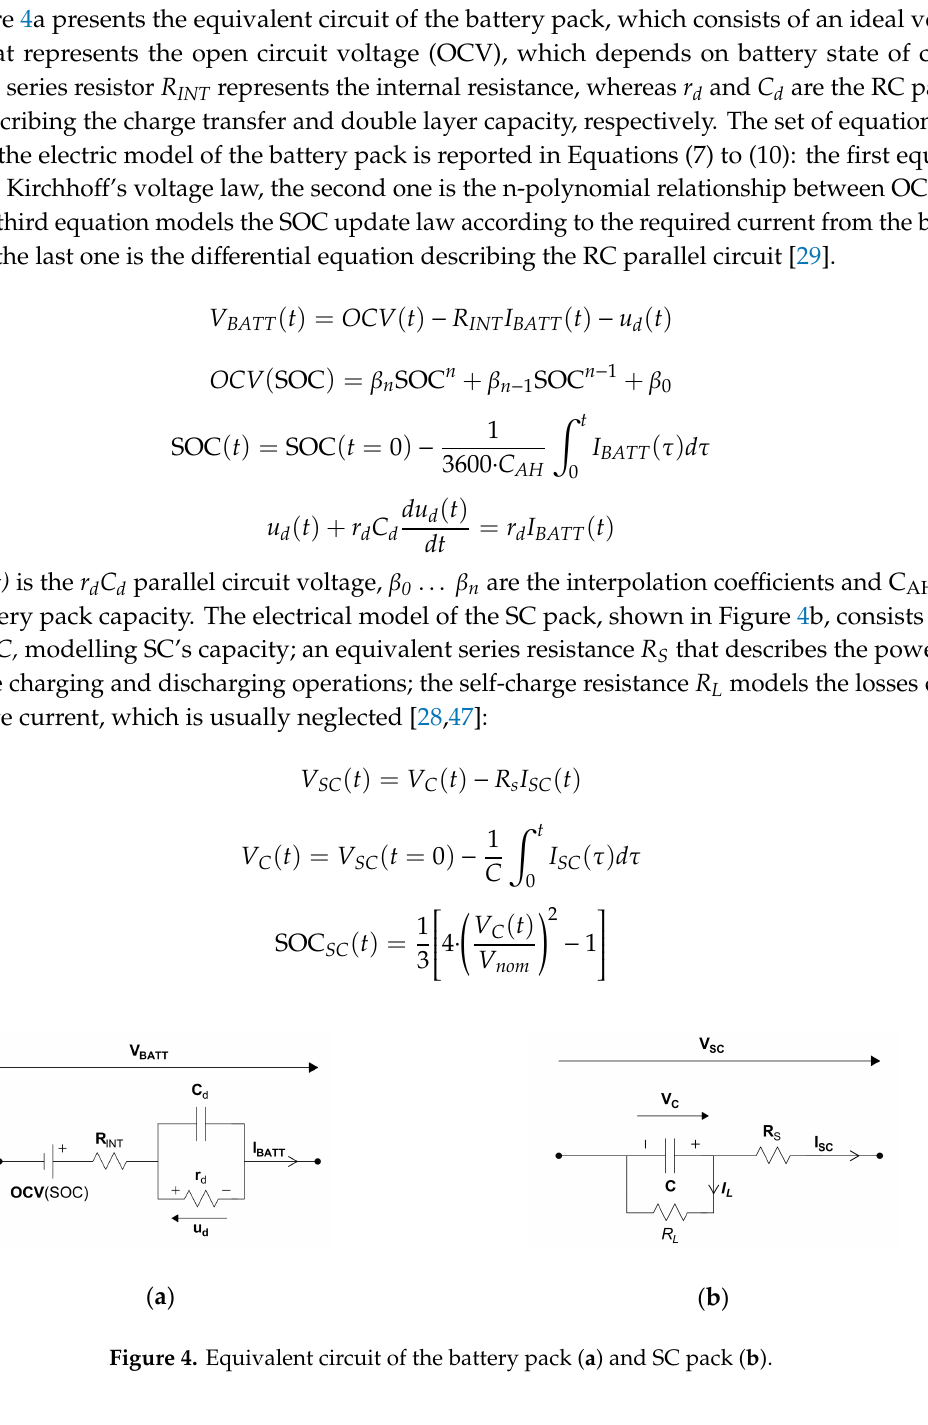
Figure 3. On-board Hybrid ESS electric model.